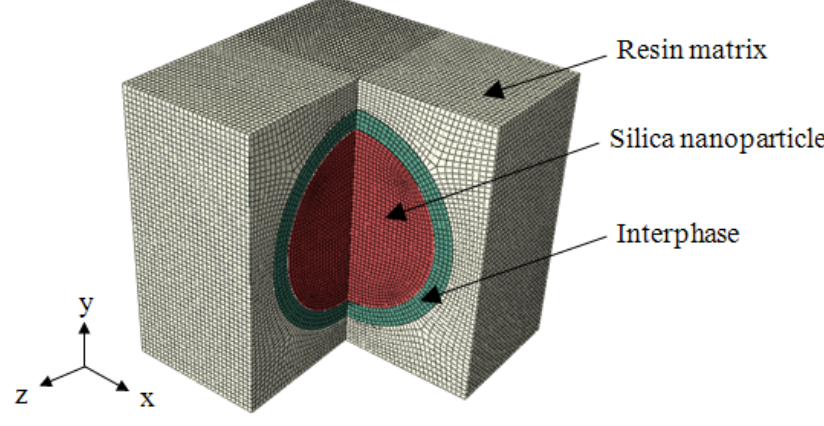
Figure 1. Three-dimensional representative volume element in a one-quarter